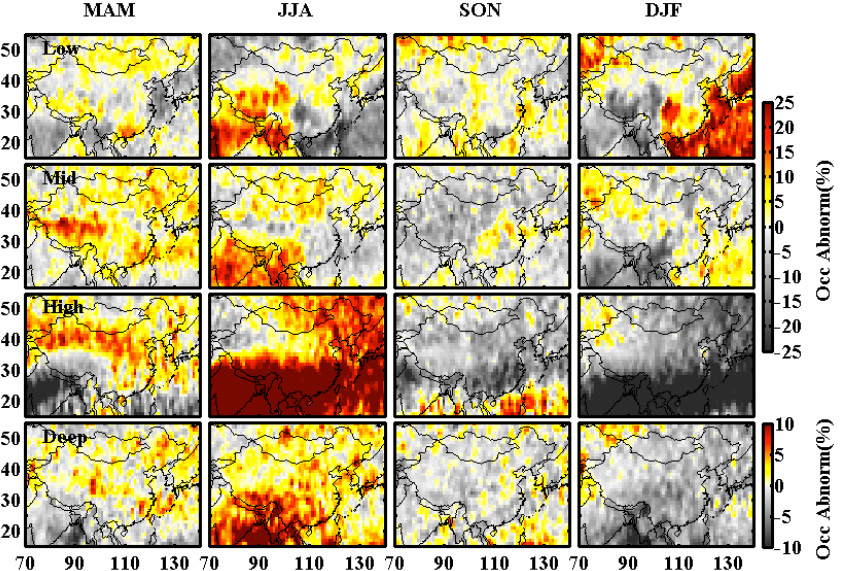
Figure 8. Similar to Figure 7, but for the seasonal anomalies.